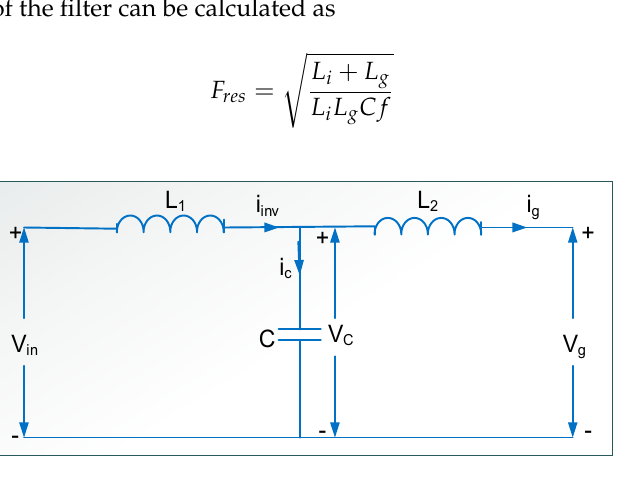
Figure 10. Topology of LCL filter.